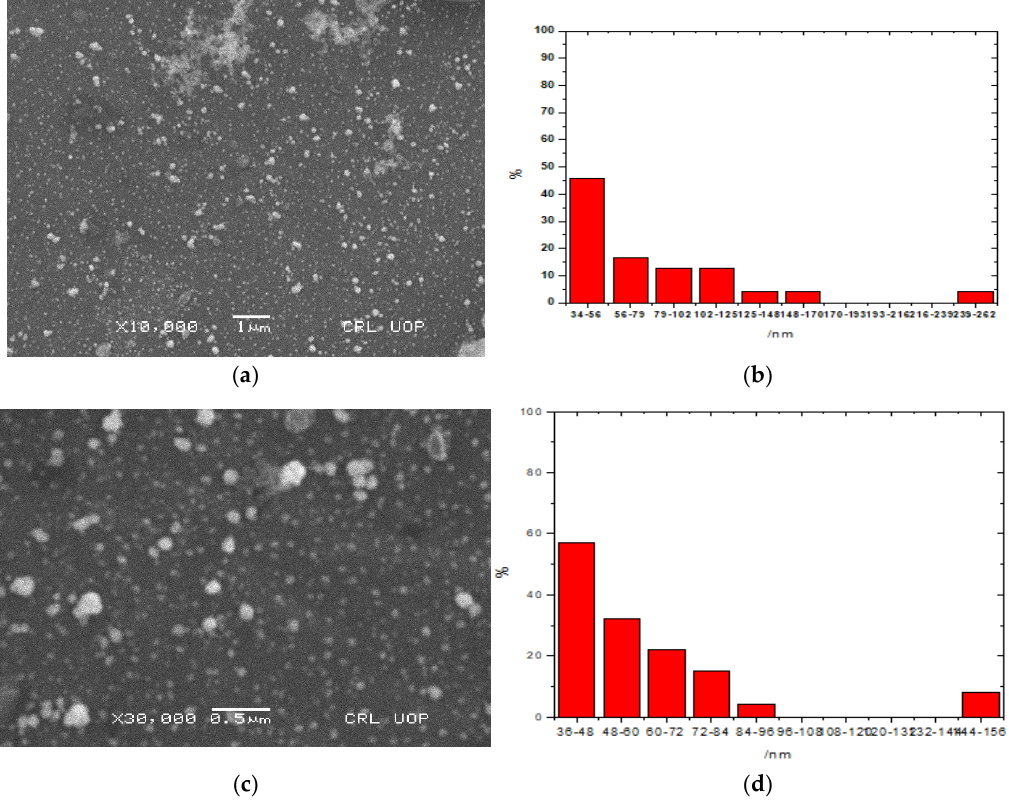
Figure 3. ( a ) SEM image of AuNPs functionalized with crude flavonoids extract of Micromeria biflora ; ( b ) size distribution percentage of AuNPs functionalized with flavonoids extract of Micromeria biflora; ( c ) SEM image of Au–amoxi; ( d ) size distribution percentage of Au–-amoxi.